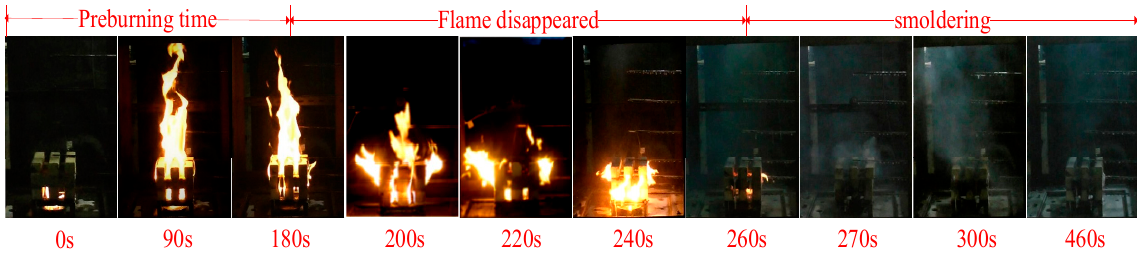
Figure 7. Flame morphology of thermosensitive hydrogel of 6wt% during the fire suppression process.